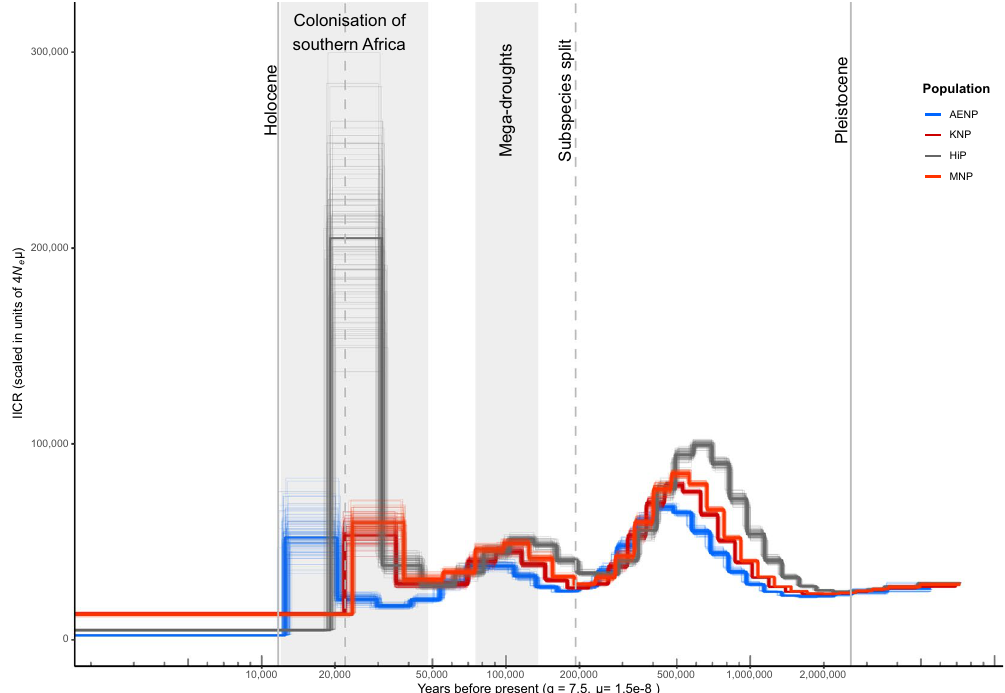
Figure 4. Pairwise sequentially Markovian coalescent (PSMC) inference of the inverse instantaneous coalescent rate (IICR) in Cape buffalo. One individual from each sampling locality is shown (AENP- A_243_14, KNP- B98_509, HiP- HC-32 and MNP- M_120_13). The x-axis represents time in years, calibrated using a generation time (g) of 7.5 years and a per site per generation mutation rate (µ) of 1.5e−8. The y-axis shows IICR, which